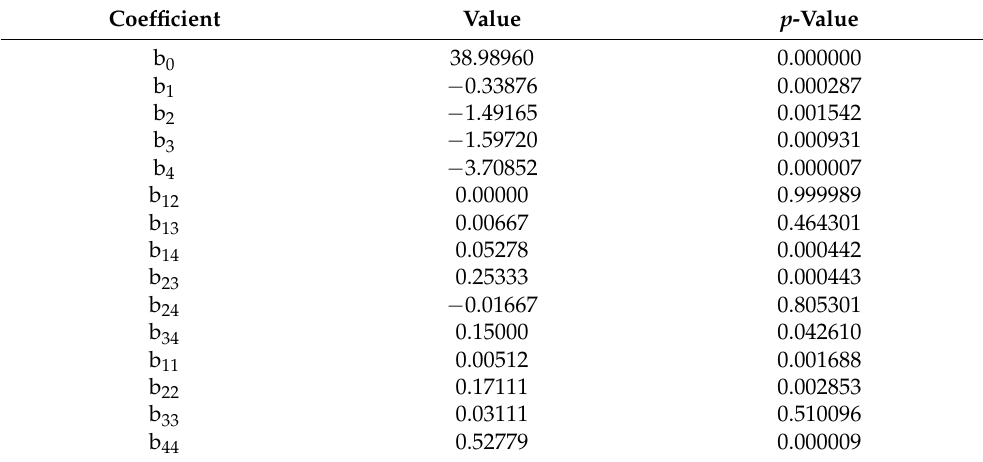
Table 6. Coefficients of regression equation and their p -values for the diameter of the inhibition zone for Aspergillus flavus SA2BSS as test microorganism.